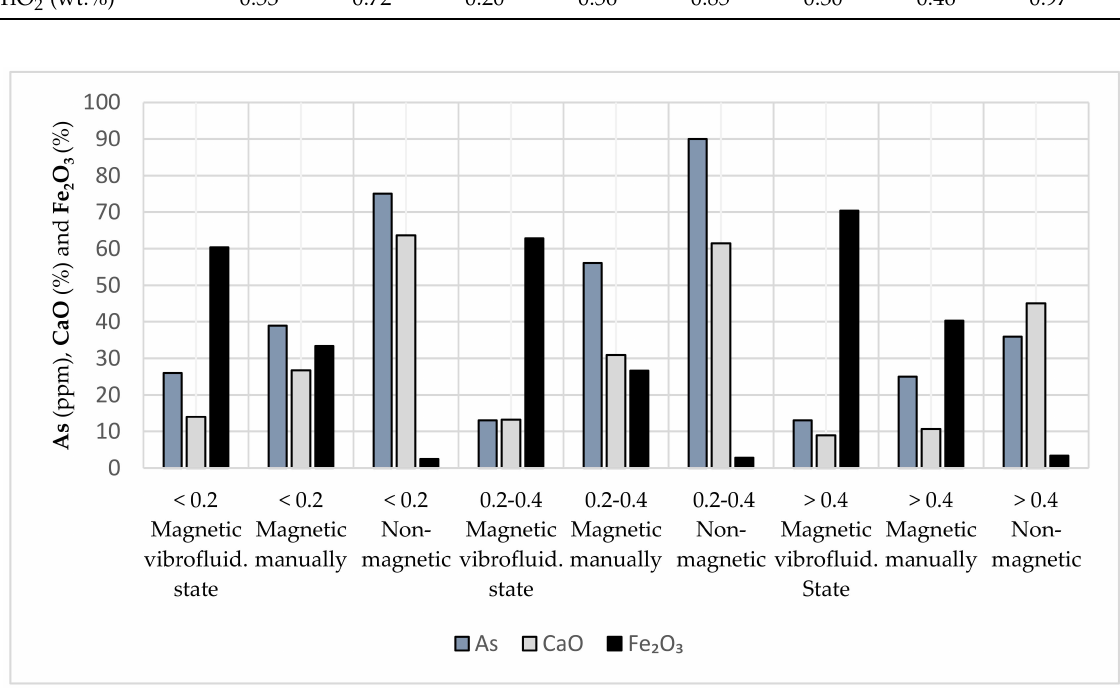
Figure 1. Distribution of As (ppm), CaO (wt.%), and Fe 2 O 3 (wt.%) in the particle-size fraction of